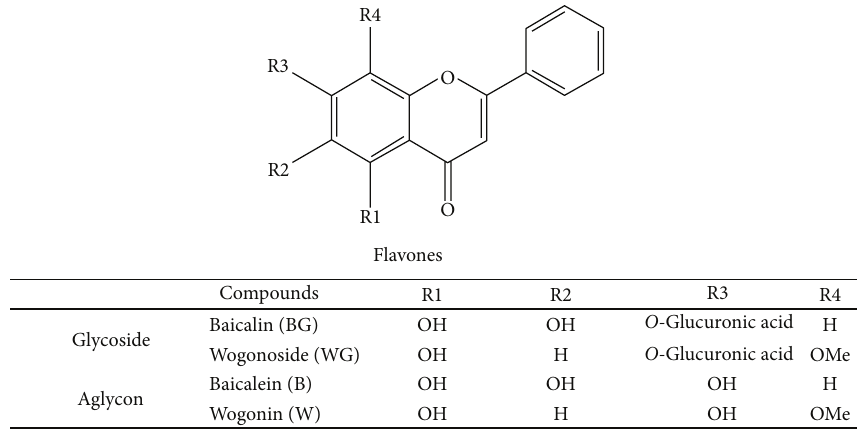
Figure 1: Chemical structure of baicalin, wogonoside, baicalein, and wogonin compounds in S. baicalensis .